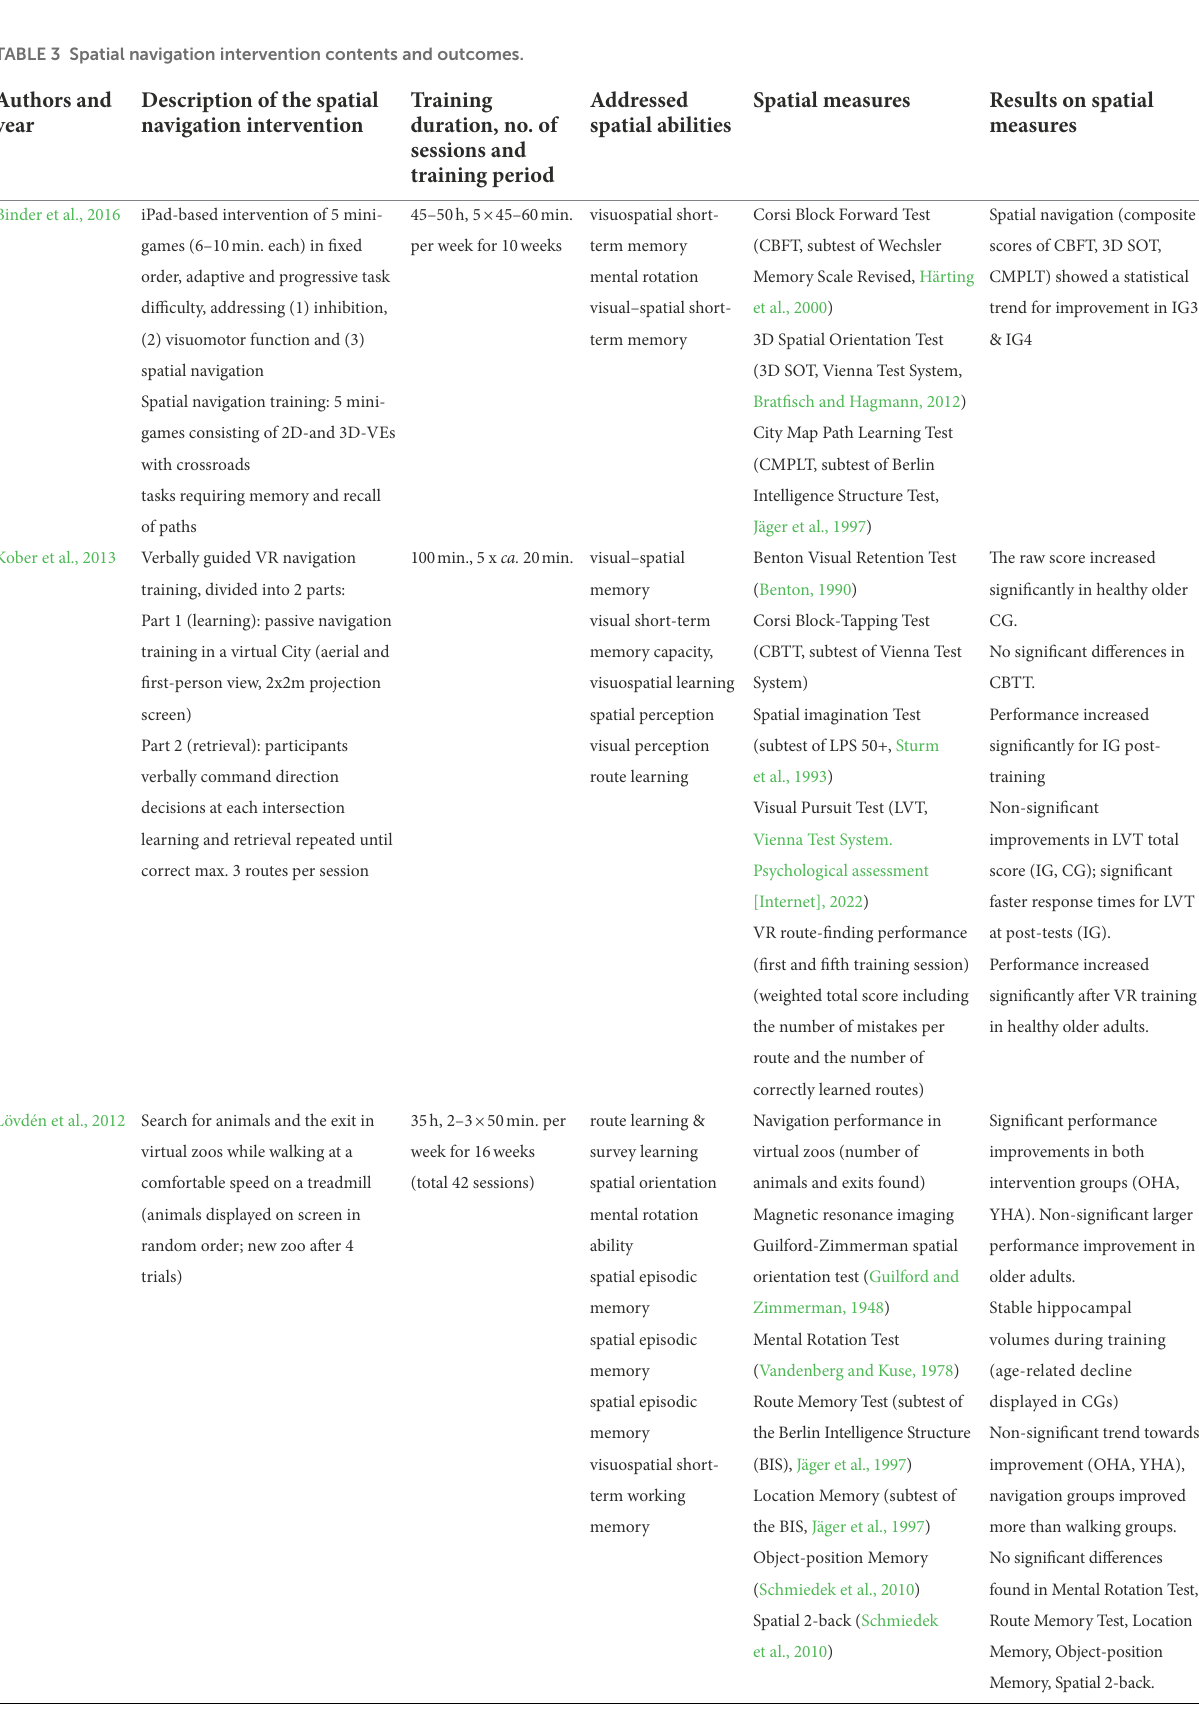
TABLE 3 Spatial navigation intervention contents and